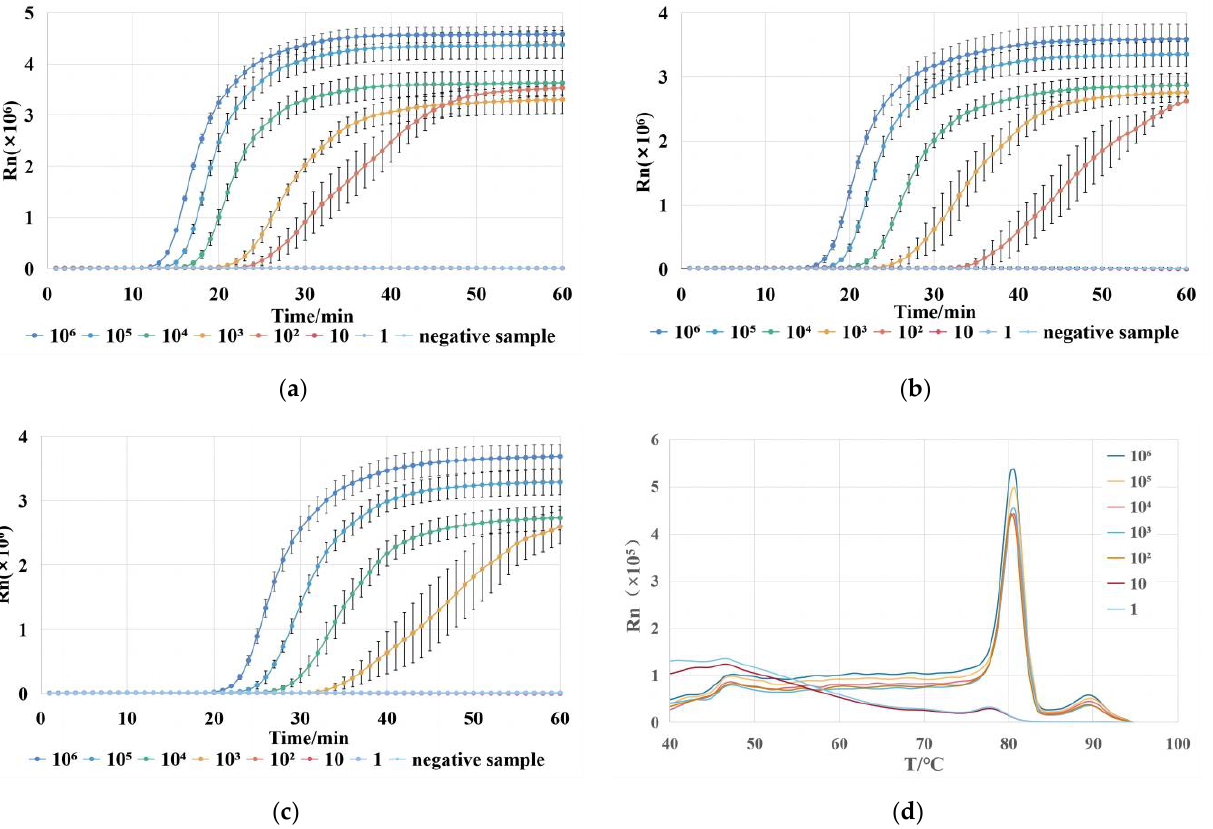
Figure 4. ( a ) Fluorescent signals of the first set of LAMP reactions for gradient dilution of VP DNA extracts of 10 6 copies/ μ L. ( b ) Fluorescent signals of the second set of LAMP reactions. ( c ) Fluorescent signals of the third set of LAMP reactions. ( d ) Melting curves of the amplified products of the first set of LAMP reactions.